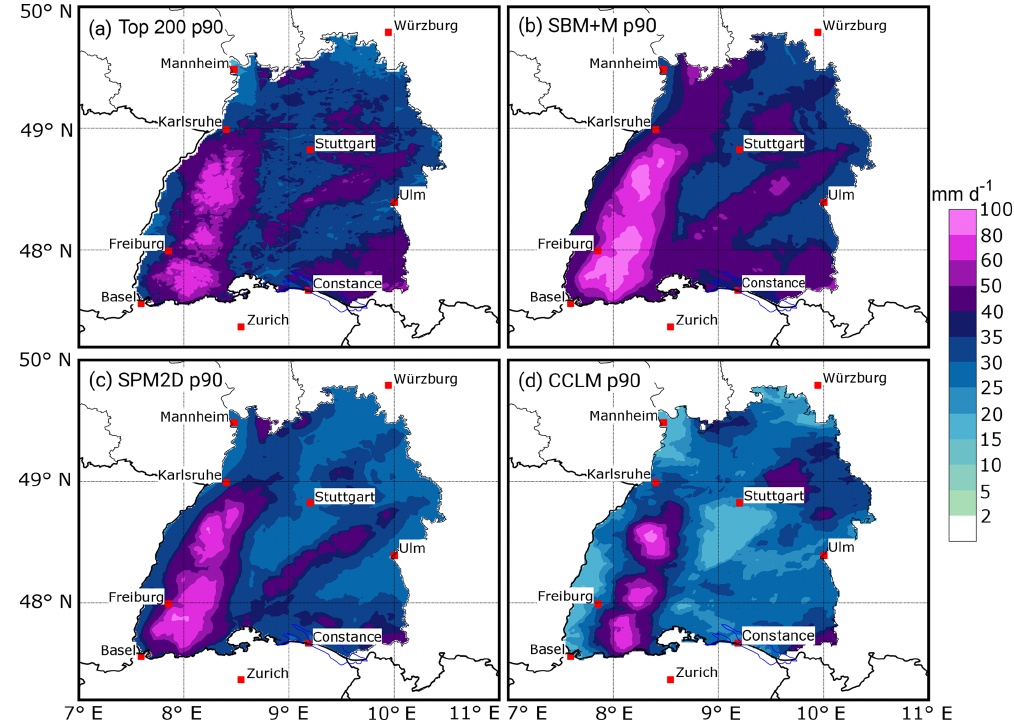
Figure 13. Precipitation fields for the 90th percentile (p90) of (a) the top200 (REGNIE) events, (b) the SBM + M part of the stochastic events, (c) the full SPM2D stochastic event set, and (d) the CCLM simulations of the top REGNIE